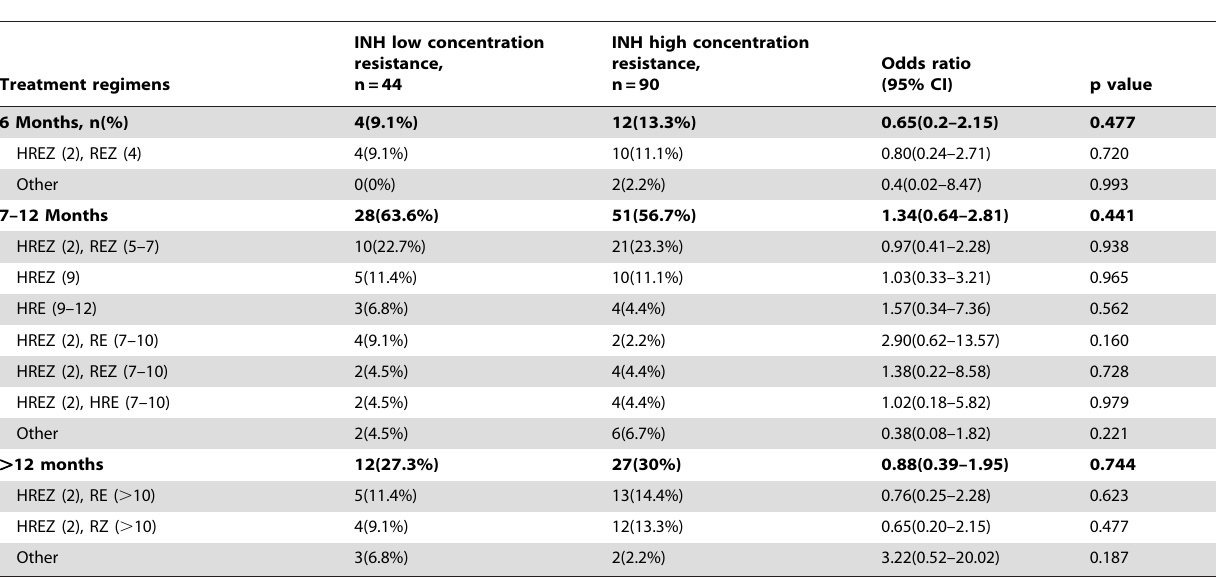
Table 2. Treatment regimens for isoniazid-monoresistant